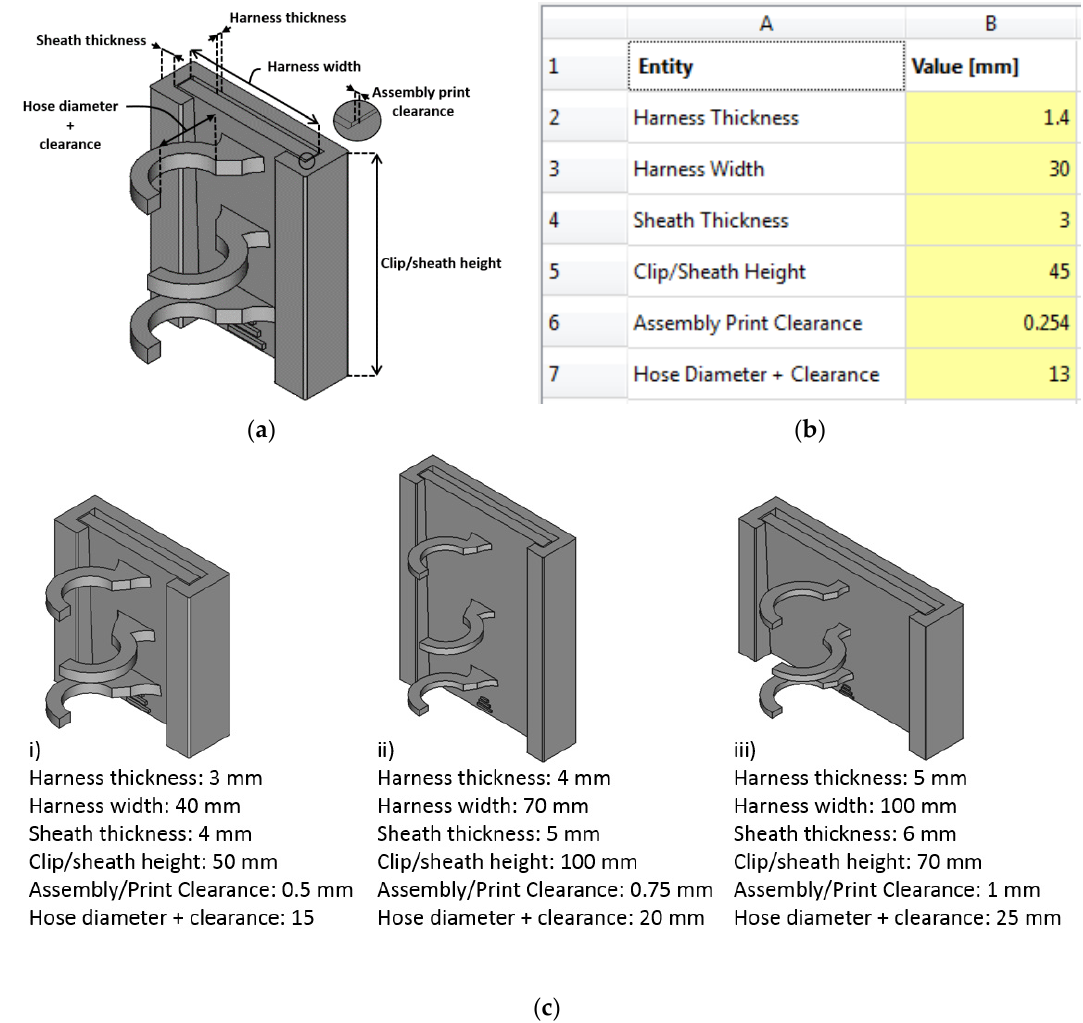
Figure 2. ( a ) The 5 + 1 input parameters of the parametric clip system equipped with a hose holder; ( b ) the 5 + 1 input parameters spreadsheet of the parametric clip system equipped with a hose holder; ( c ) three variants of the parametric clip system equipped with a hose holder.